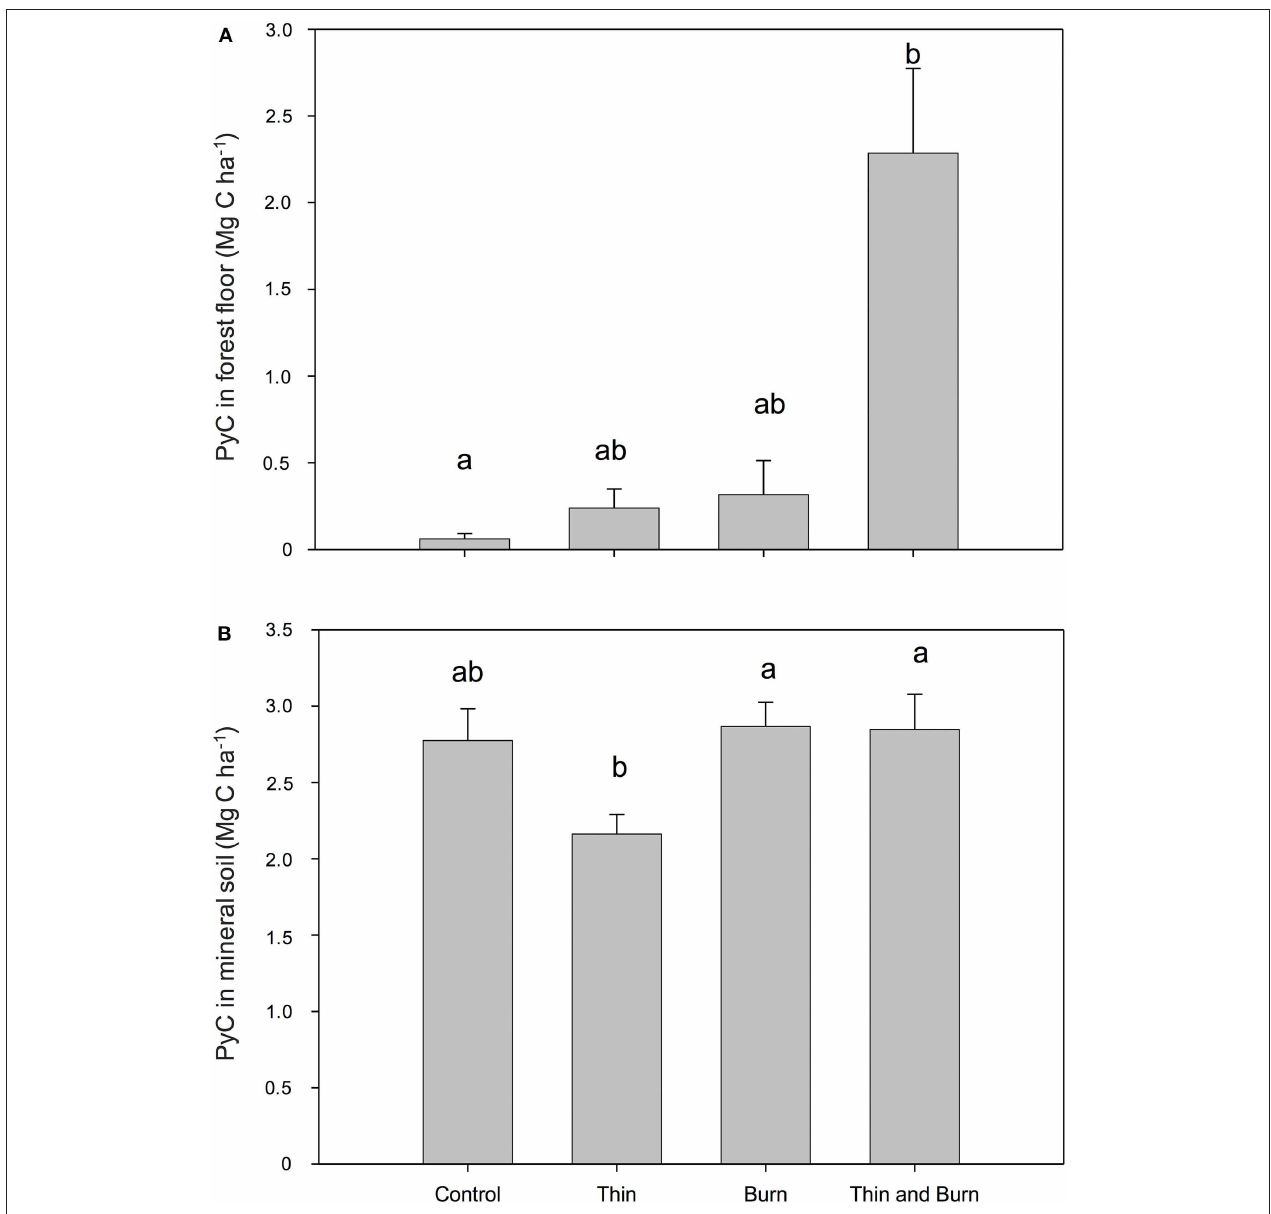
FIGURE 2 | Pyrogenic carbon (PyC) (Mg C ha − 1 ) in the (A) O horizon and (B) mineral soil as influenced by thinning with or without prescribed fire in the Fire and Fire Surrogates study in Western Montana, USA. Data were compared using Tukey’s postdoc test following ANOVA. Error bar indicates 1 × standard error. Columns with the same letter are not significantly different at P =